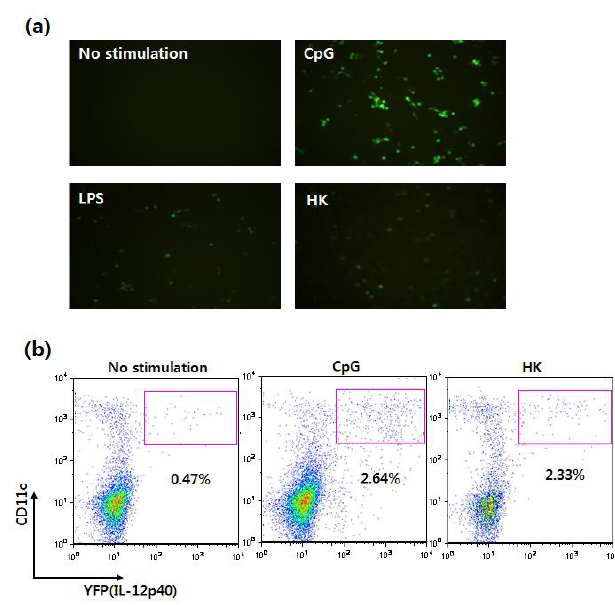
Figure 9. Visualization of IL-12 induction by DCs derived from cytokine reporter mice. (a) Flt3L-cultured BMDCs were stimulated with vehicle, CpG, LPS, or heat-killed